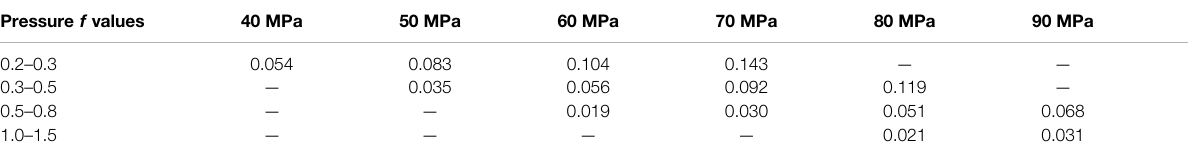
TABLE 2 | The coal-dropping speeds in coal seams with different Protodyakonov coef fi cients under different cutting pressures. Pressure f values